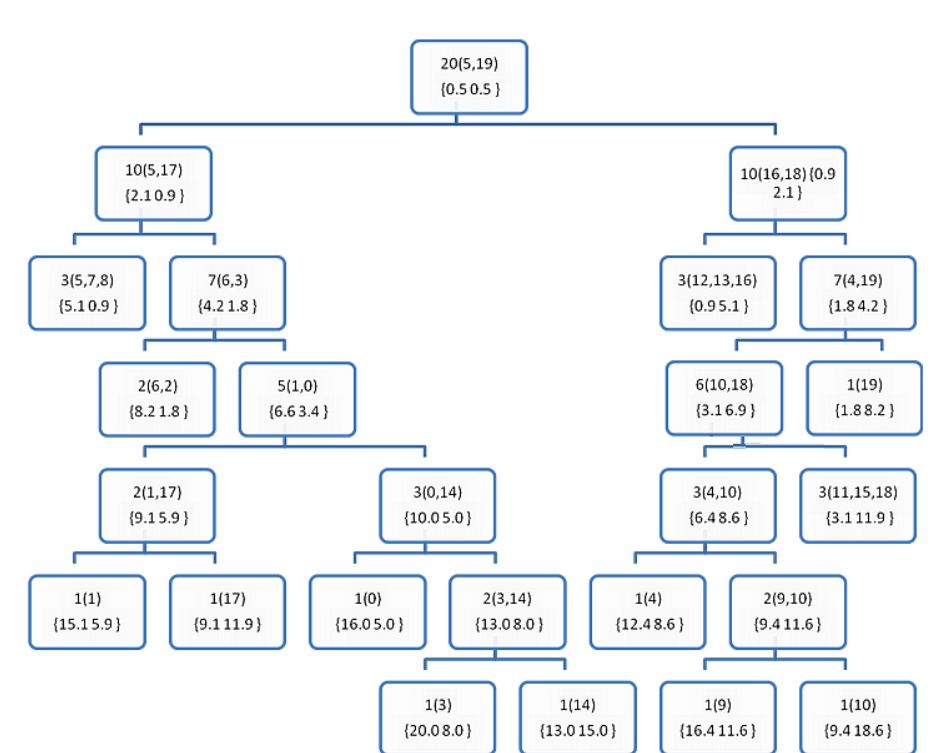
Figure 6. The resultant decision tree after applying the training phase of the DT1+ on the sample data from Table 1. The number outside the rounded brackets is the counter of the examples hosted by each node, and those inside the rounded brackets are the index of the examples in a leaf node, or the furthest points (P1 and P2) otherwise. The numbers in the curly brackets {} shows the probabilities of the classes at each node.